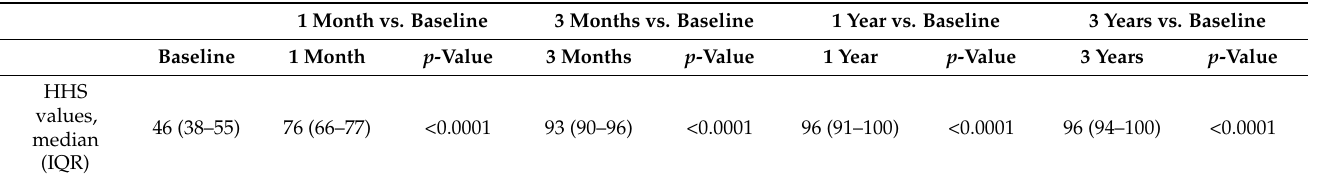
Table 2. Change in the Harris hip score (HHS) values between each time-point compared to the baseline